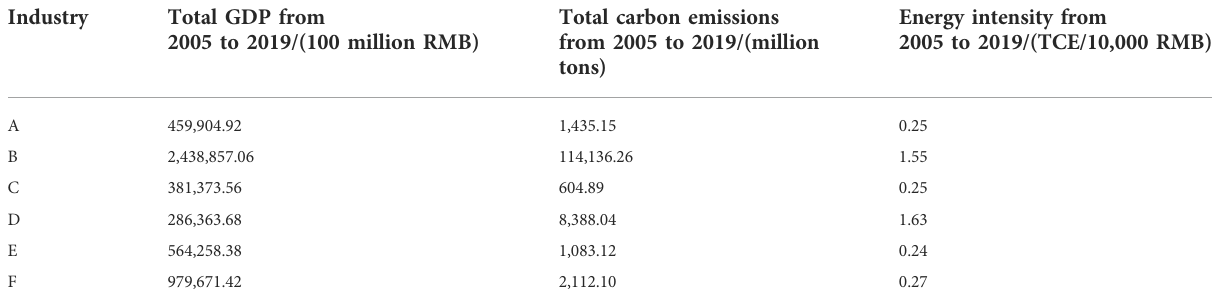
TABLE 2 Indicator data of carbon permit allocation.